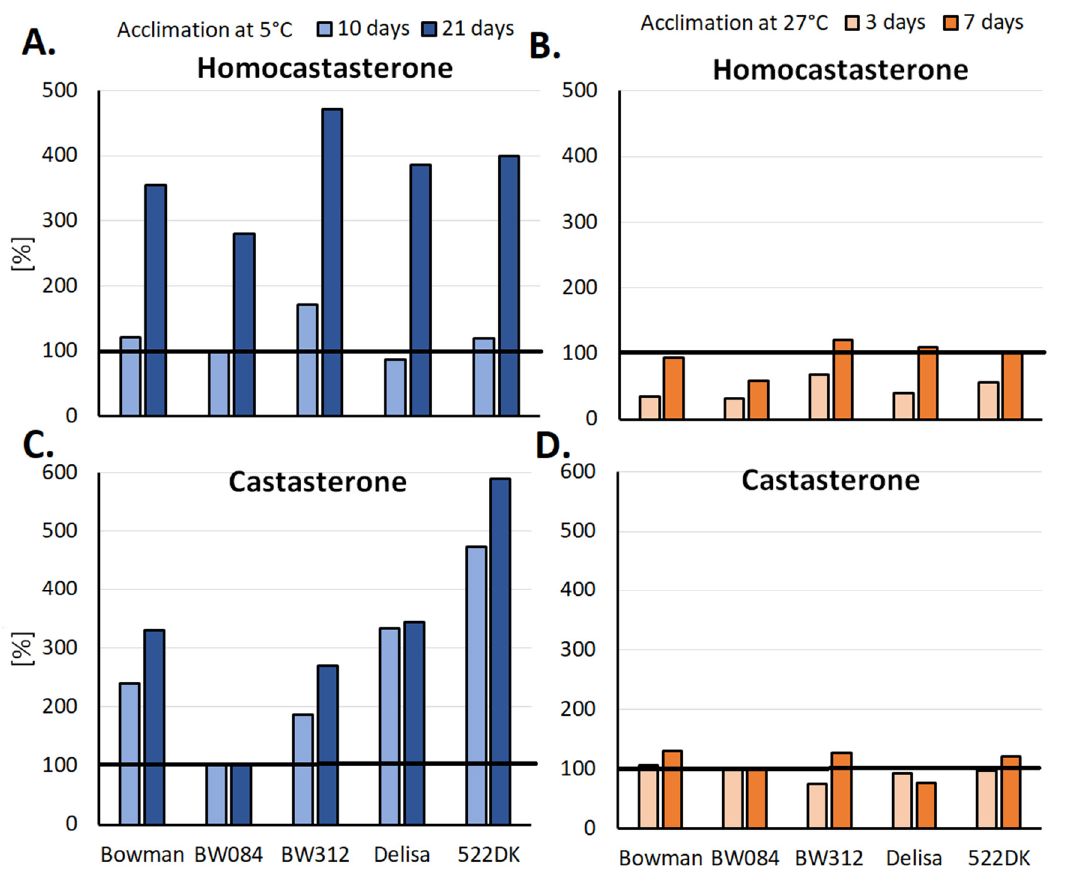
Figure 3. Relative percentage changes in the homocastasterone and castasterone content in the barley plants that had been acclimated at 5 °C ( A , C ) and 27 °C ( B , D ) relative to plants that had been acclimated at 20 °C. The results that were obtained for the plants that had been grown at 20 °C were considered to be 100% and are indicated by the horizontal black line. Original data of BR accumulation are available in [13]. Bowman—a reference cultivar for two NILs: BW084—plants with disturbances in the early stage of the BR biosynthetic pathway and BW312—plants with a BRI1 receptor defect. Delisa—reference cultivar for the 522DK mutant (plants with disturbances in the late stage of the BR biosynthesis pathway).